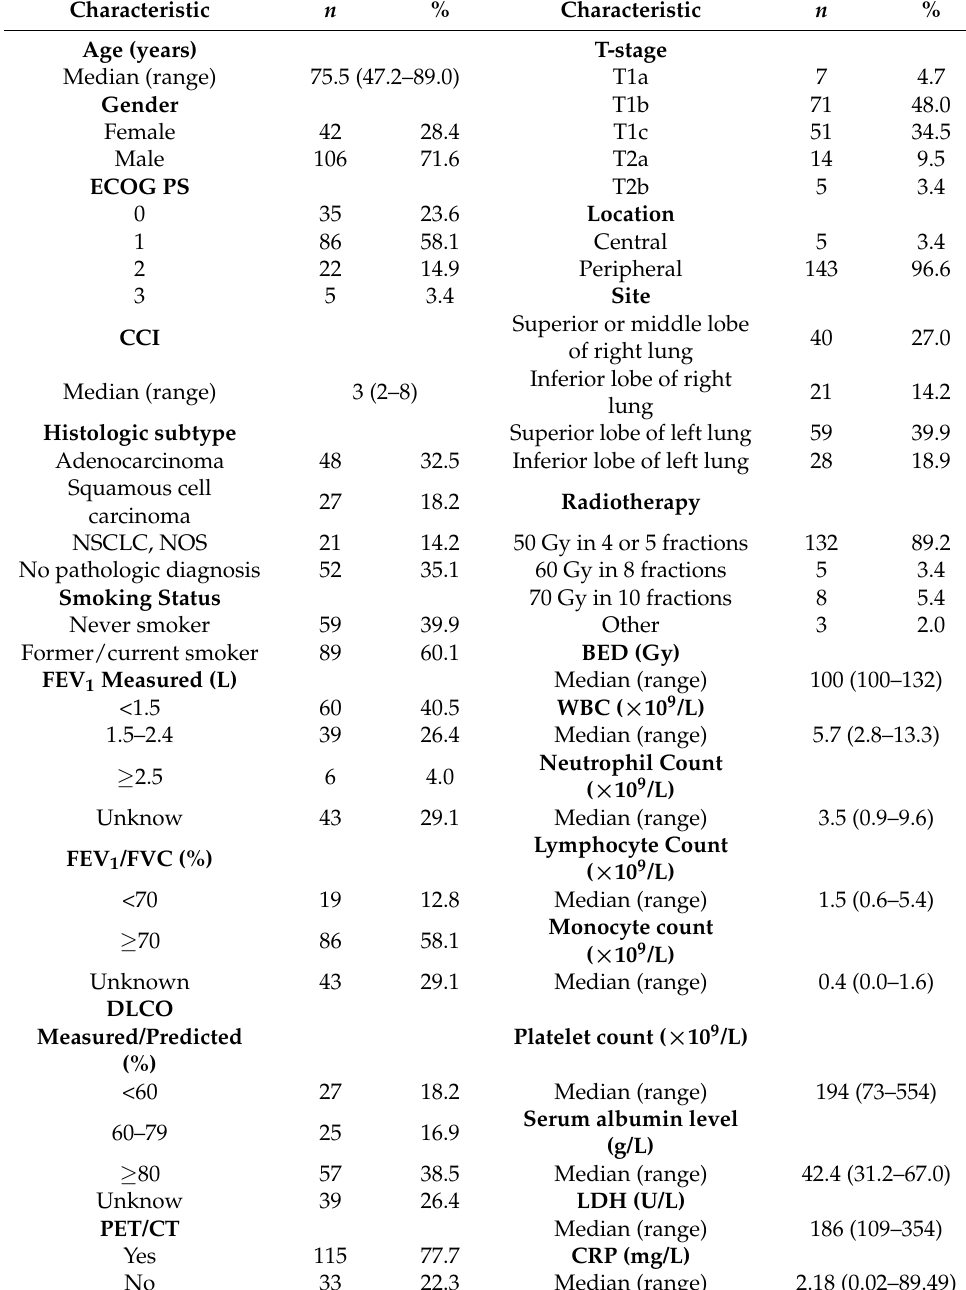
Table 1. Demographics, tumor, and treatment characteristics of